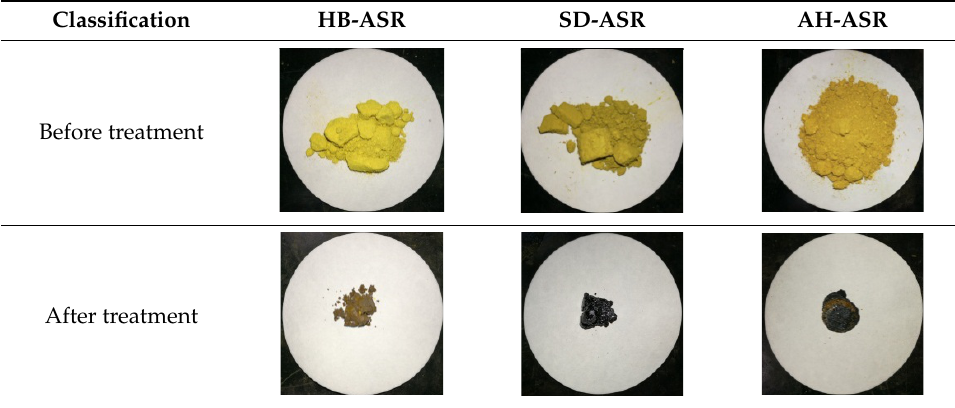
Table 2. Photos of the raw and treated ASRs.